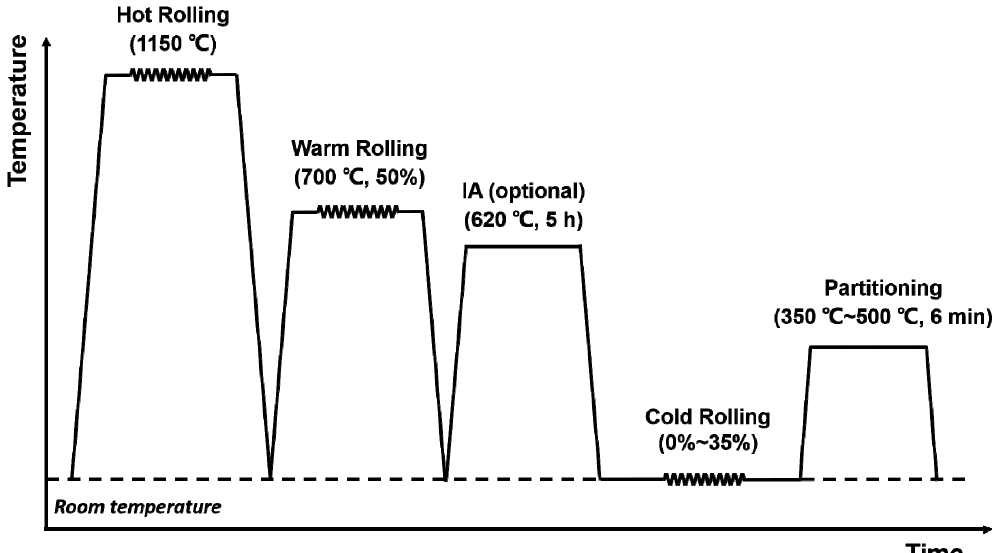
Figure 2. Schematic illustration of the thermomechanical process for producing deformed and partitioned (D&P) steel. The room temperature mechanical properties of the HR + WR samples and